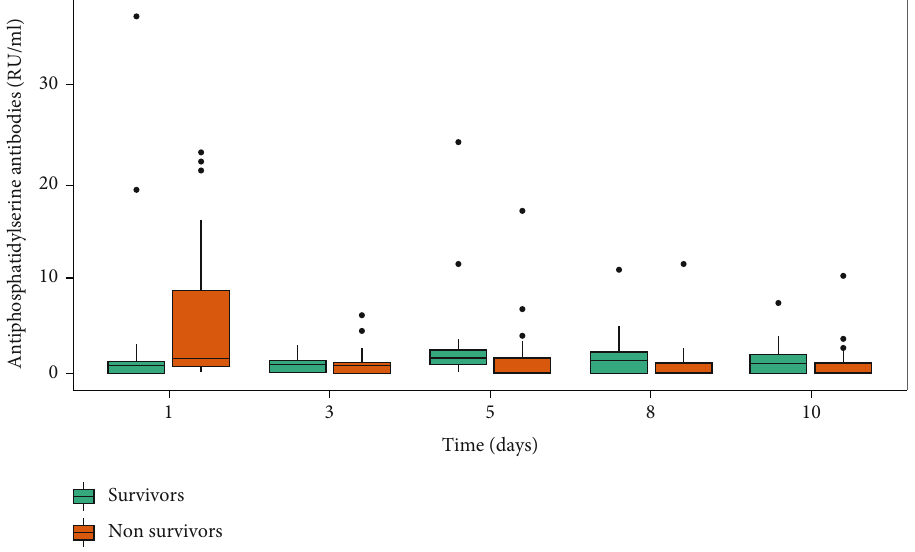
Figure 2: Association of antiphosphatidylserine antibodies (aPS) with in-hospital mortality. Table 2: Variables associated with mortality in multivariate regression